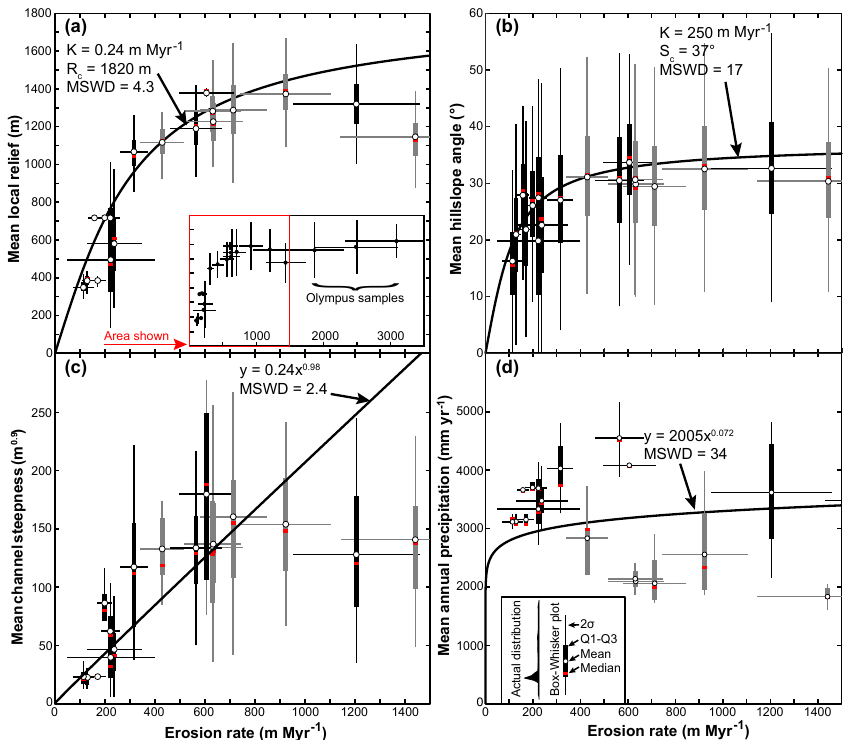
Figure 6. Plot of erosion rates with basin-averaged metrics. Due to the high degree of variation within a single basin, we have plotted basin metric data as box-and-whisker plots. Thin vertical bars denote 2 standard deviations. Thick vertical bars denote the central 50% of the data between the first and third quartiles (Q1 and Q3). Red bars denote the medians and white circles denote means. Horizontal bars show 2 σ confidence intervals on erosion rates. West and east side basins are shown in black and grey, respectively. (a) Erosion rate versus mean local relief (5km relief). Inset shows higher erosion rate samples not featured in other panels. (b) Erosion rate versus mean hillslope angle. (c) Erosion rate versus mean channel steepness. (d) Erosion rate versus mean annual